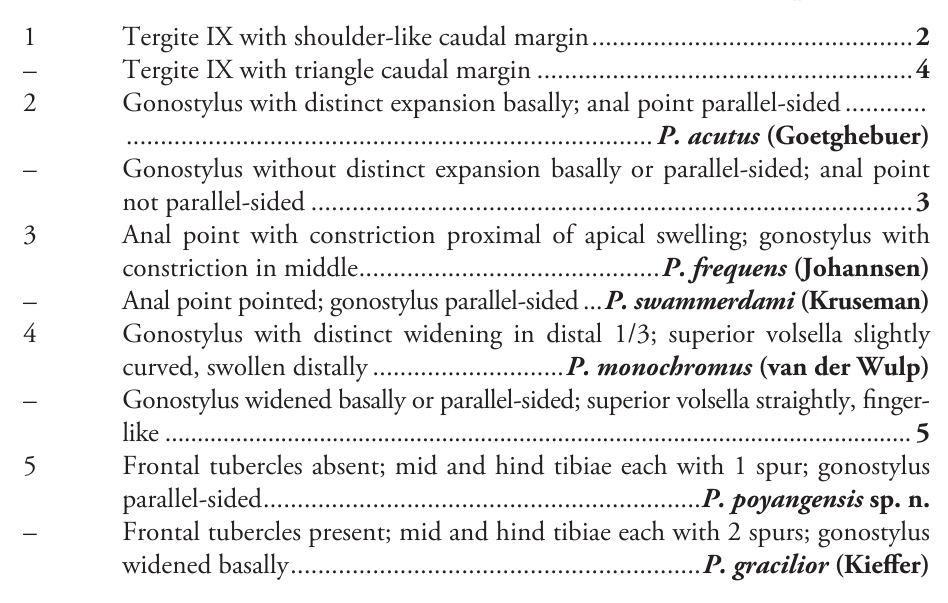
Chironomus frequens Johannsen, 1905: 230. – Malloch (1915: 452). Chironomus ( Cryptochironomus ) lhoneuxi Goetghebuer, 1921b: 168. Cryptochironomus longiforceps Kieffer, 1921d: 66. Harnischia ( Harnischia ) frequens (Johannsen). – Townes (1945: